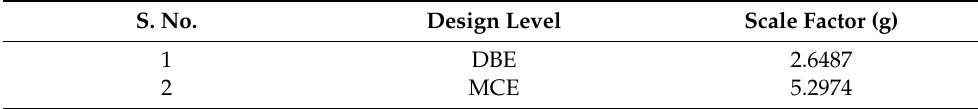
Table 2. Scale factors at each design level.